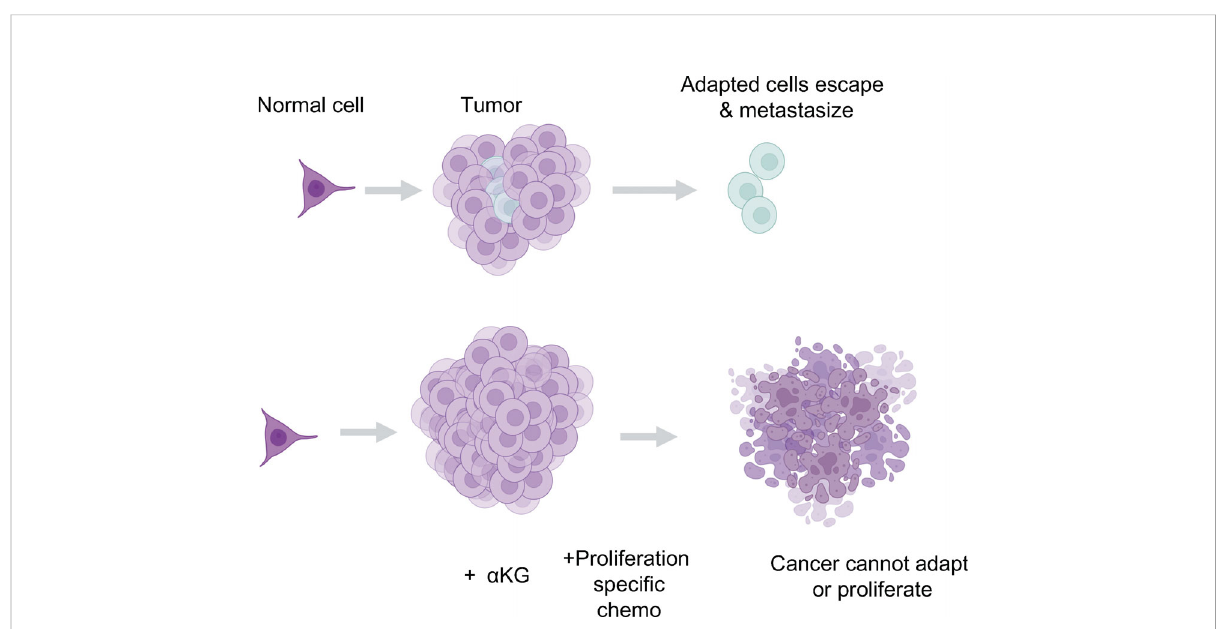
FIGURE 6 The potential for a KG to synergize with standards of care as a therapeutic. We propose that supplying the breakdown of the glutamine supply line is a potentially dangerous therapeutic strategy. Instead, we propose a combination of proliferative targeting drugs currently available that do not allow tumor growth, in tandem with glutamine or a KG supplementation to maintain the differentiated and metabolically maladapted state of the cell limiting its ability to survive in a tumor or more importantly, outside of the tumor and into other